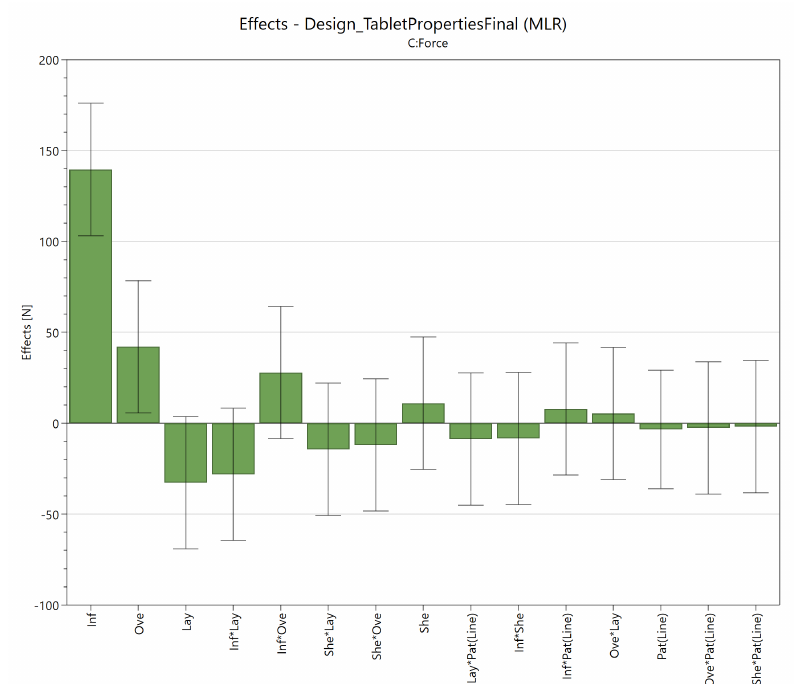
Figure 3. Effect plot of the diametral compression force including 95% confidence intervals for infill (Inf), overlap (Ove), number of shells (She), layer height (Lay) and infill pattern (Pat) with their interactions (*) displayed as